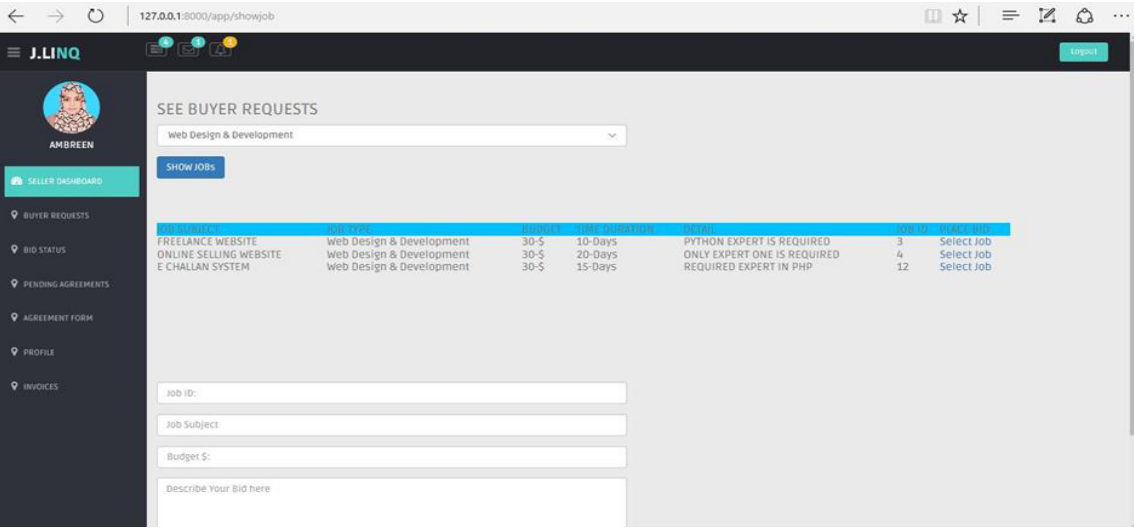
Figure 14. List of the posted job by the same buyer in the platform.